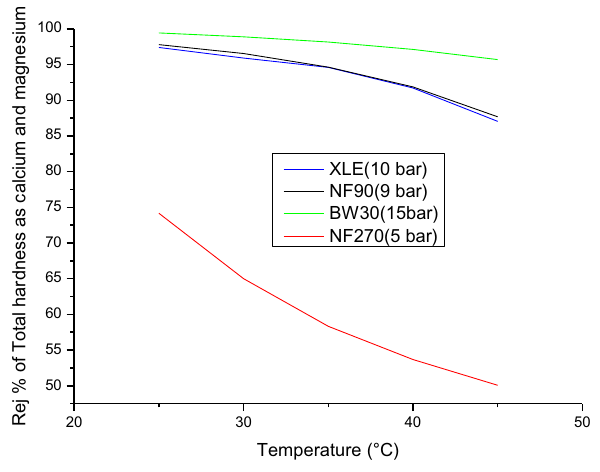
Fig. 12 Effect of temperature on sulfate % removal at optimum feed pressure for conf a